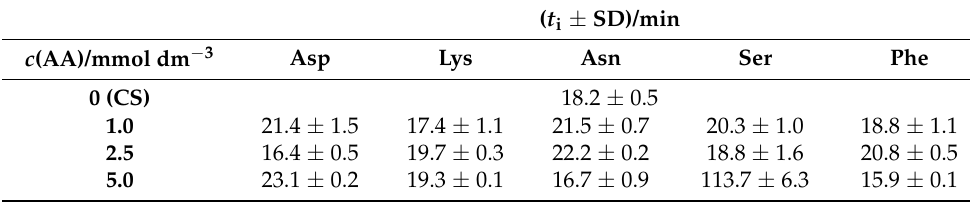
Figure 1. Representative pH vs. time curves obtained in the control system and systems containing amino acids: ( a ) aspartic acid (Asp), ( b ) lysine (Lys), ( c ) asparagine (Asn), ( d ) serine (Ser) and ( e ) phenylalanine (Phe). c (CaCl 2 · 2H 2 O) = c (Na 2 HPO 4 ) = 5 mmol dm − 3 , c (NaCl) = 0.15 mol dm − 3 , pH initial = 7.4, ϑ = (25.0 ± 0.1) ◦ C, magnetic stirring. Table 1. Average induction times ( t i ) and corresponding standard deviations obtained from pH vs. time curves from 3 measurements in the control system (CS) and systems containing amino acids. c (CaCl 2 · 2H 2 O) = c (Na 2 HPO 4 ) = 5 mmol dm − 3 , c (NaCl) = 0.15 mol dm − 3 , pH initial = 7.4, ϑ = (25.0 ± 0.1) ◦ C, magnetic stirring. Asp—aspartic acid, Lys—lysine, Asn—asparagine, Ser—serine,